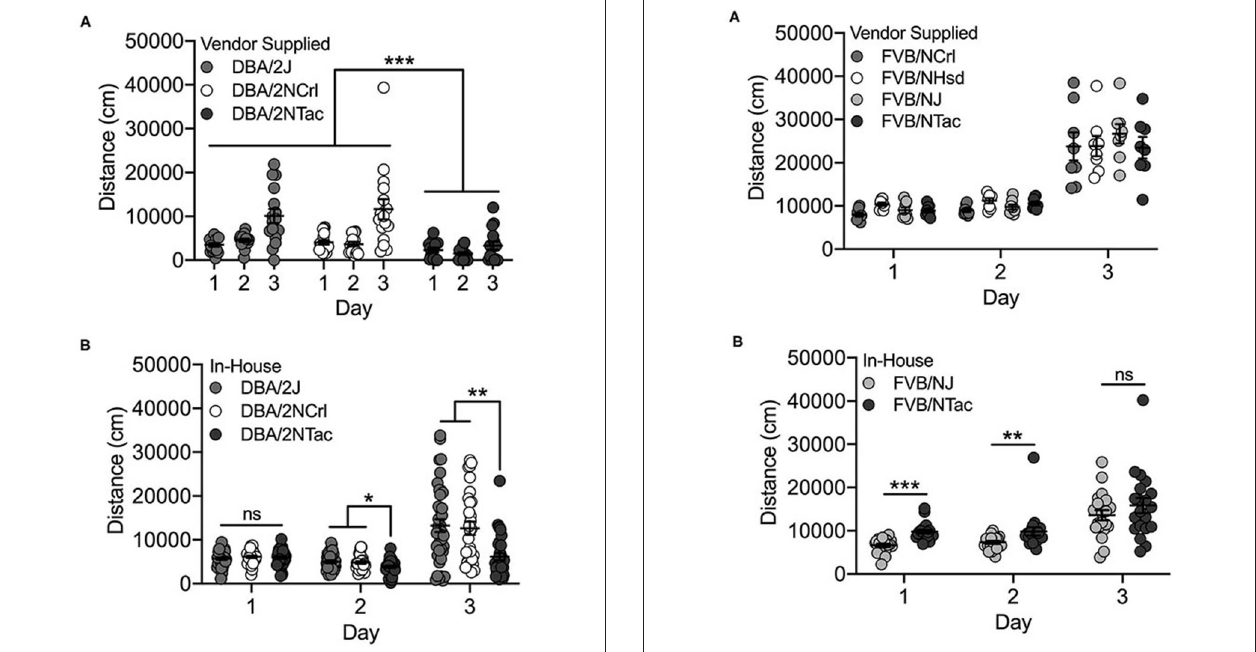
FIGURE 4 | DBA/2NTac mice are significantly less active than DBA/2J and DBA/2NCrl mice. (A) All vendor-supplied DBA/2 substrains are significantly more active in response to cocaine on Day 3 vs saline on Days 1 and 2. DBA/2NTac mice are significantly less active than mice from both DBA/2J and DBA/2NCrl substrains regardless of day. (B) DBA/2 substrains bred in-house are also significantly more active in response to cocaine on Day 3 compared with saline on Days 1 and 2. DBA/2NTac mice are significantly less active than DBA/2J and DBA/2NCrl mice on Days 2 and 3, but not on Day 1. Each data point represents an individual mouse, error bars are standard error of the mean. * p < 0.05, ** p < 0.01, *** p < 0.001.